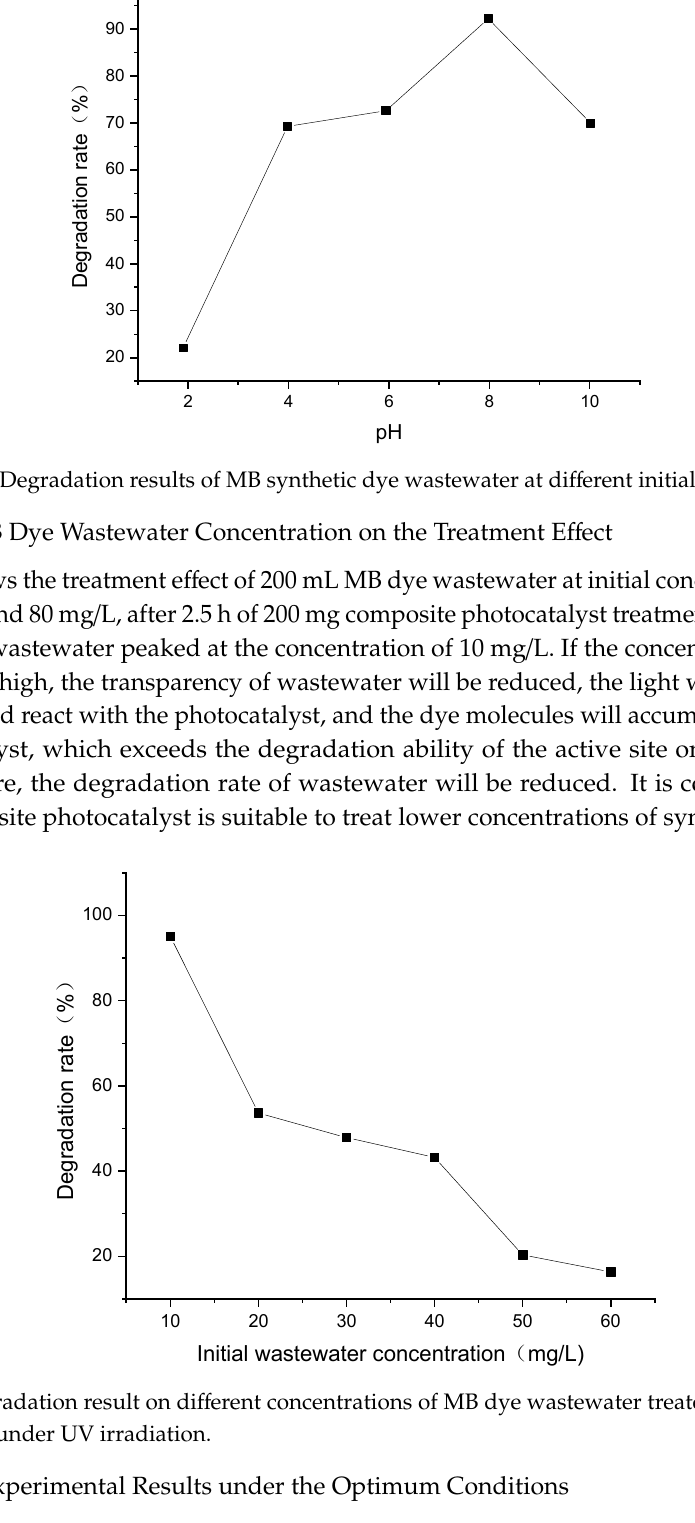
Figure 6. Degradation results of MB synthetic dye wastewater at different initial pH values.